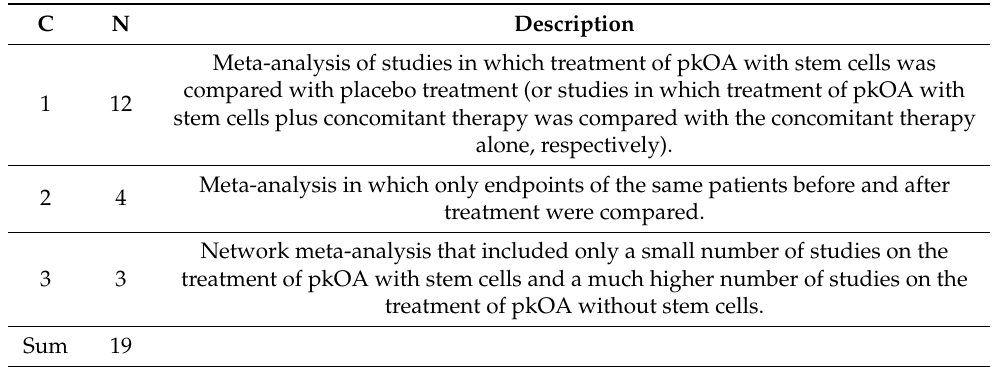
Table 4. Type of analysis performed in the meta-analyses summarized in Table S2 in which treatment of primary knee osteoarthritis with stem cells was